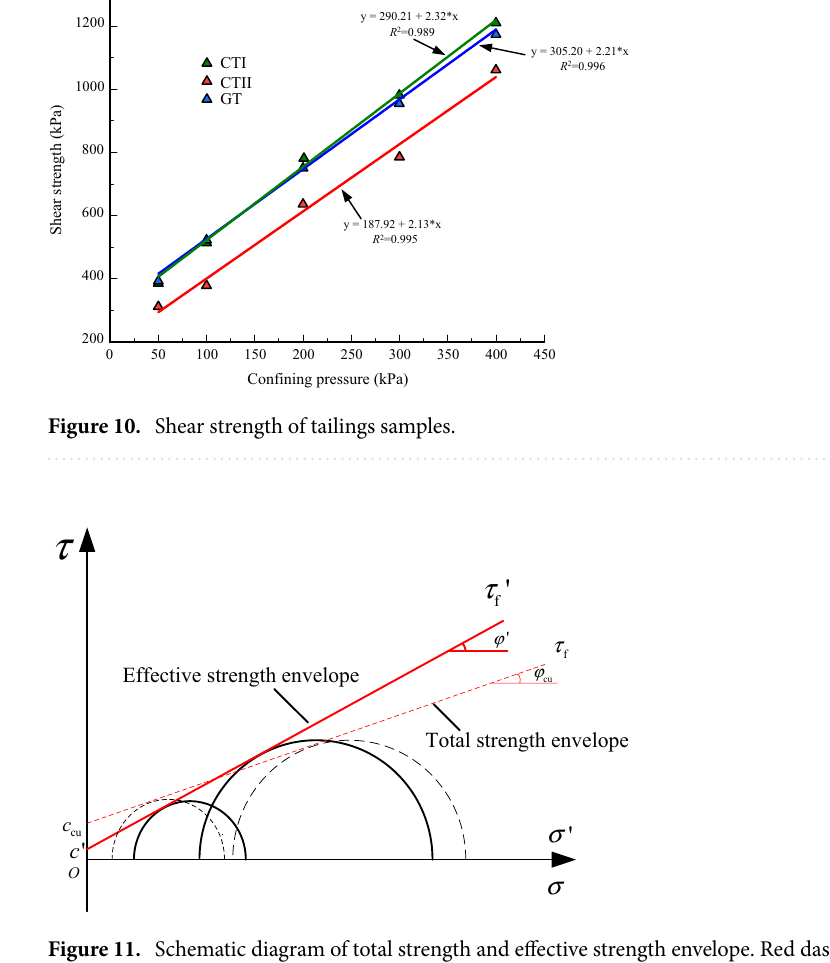
Figure 11. Schematic diagram of total strength and effective strength envelope. Red dashed line drawn in σ − τ space. Red solid line drawn in σ’ − τ space.